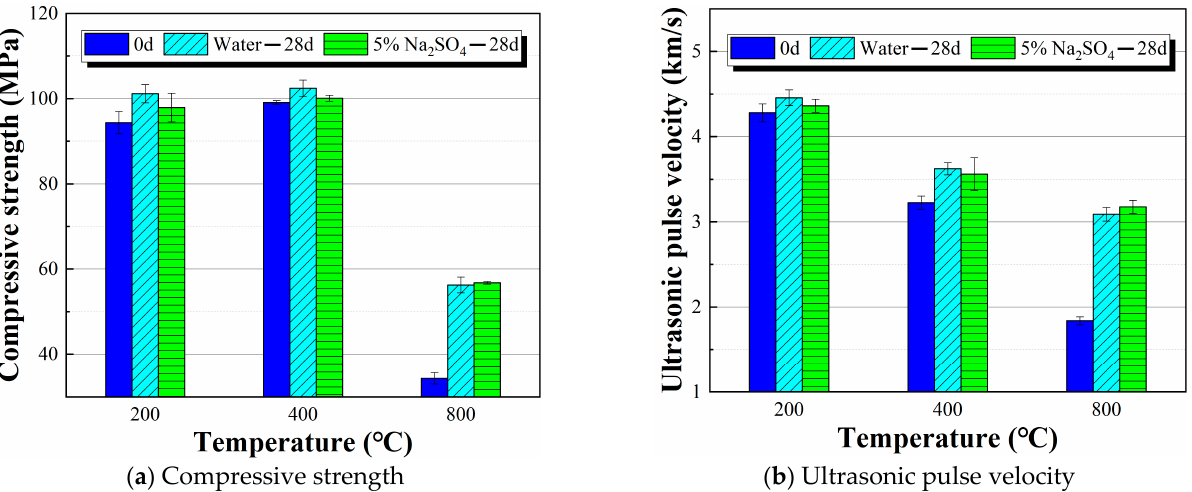
Figure 15. Mechanical properties of UHPC after exposure to high temperatures and self-healing.